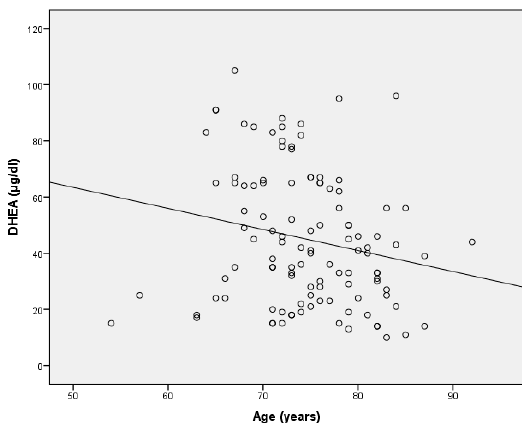
Figure 4. GH decline with age.